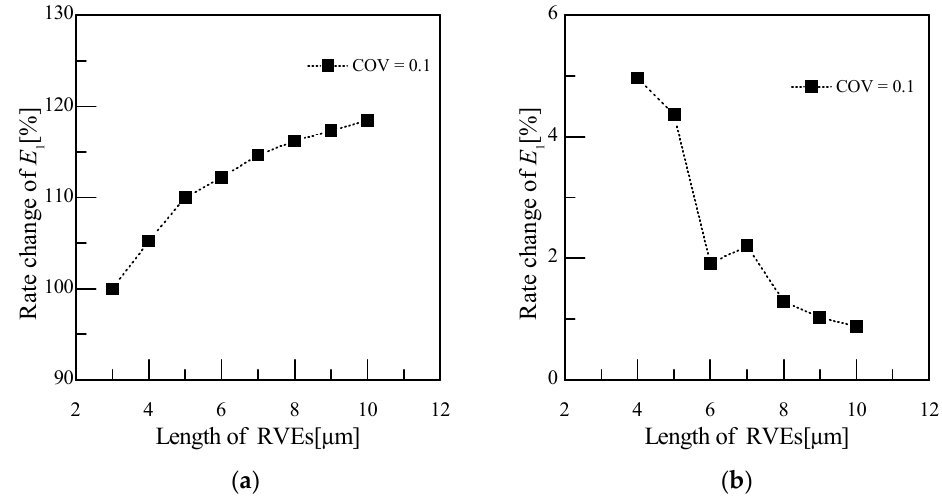
Figure 11. Changes in the effective properties according to increase in the RVE length: ( a ) increasing rate of the effective properties based on a 3 µm RVE according to increasing RVE length; ( b ) difference in the rate of change in the effective properties with increasing RVE length.